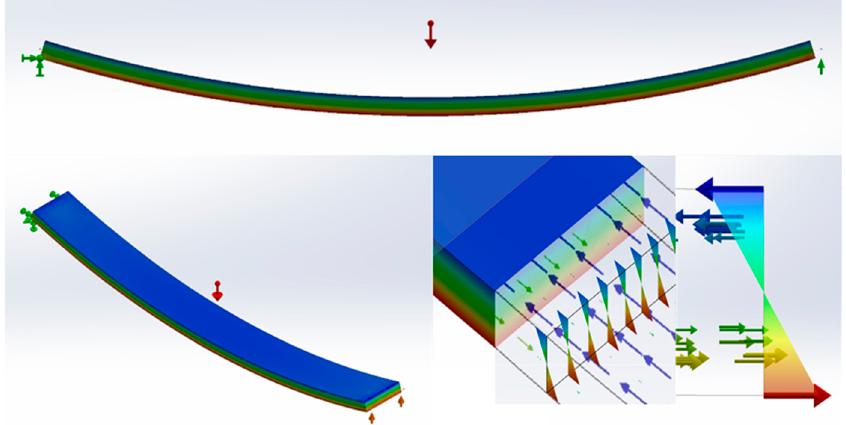
Figure 5. Scheme of tensile and compression forces combination during the flexural test. In the color range green to red the tensile forces and in the color range blue the compressive forces.